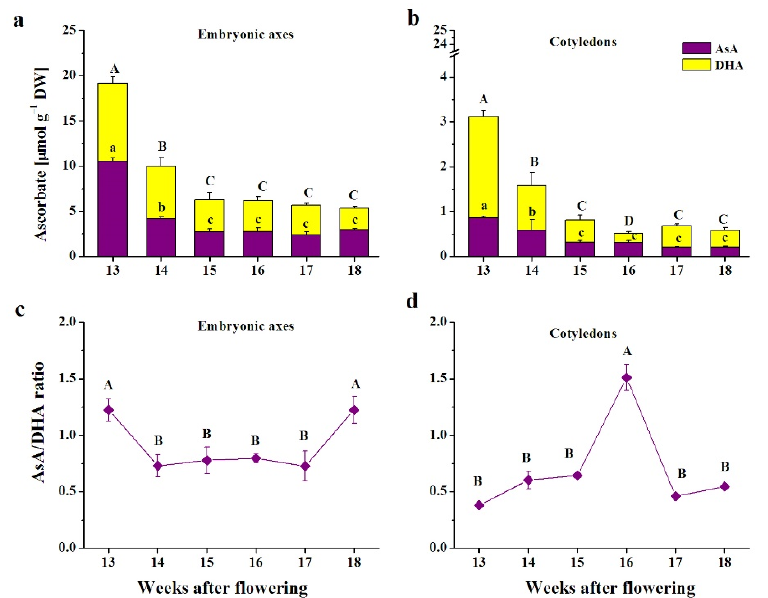
Figure 1. Levels of the reduced form (ascorbic acid, AsA) and oxidized (dehydroascorbate, DHA) form of ascorbate ( a , b ) and the AsA/DHA ratio ( c , d ) in embryonic axes ( a , c ) and cotyledons ( b , d ) of developing beech seeds. Data are shown as the means ± standard deviation ( n = 3). Different letters indicate the statistical significance (one-way ANOVA, followed by Tukey’s test at p < 0.05). The capital letters refer to DHA ( a , b ).